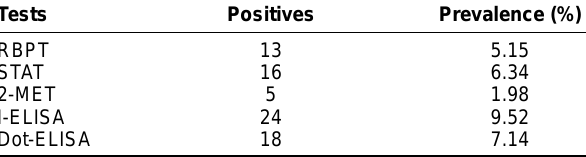
Table-1: Prevalence rates by different serological tests Tests